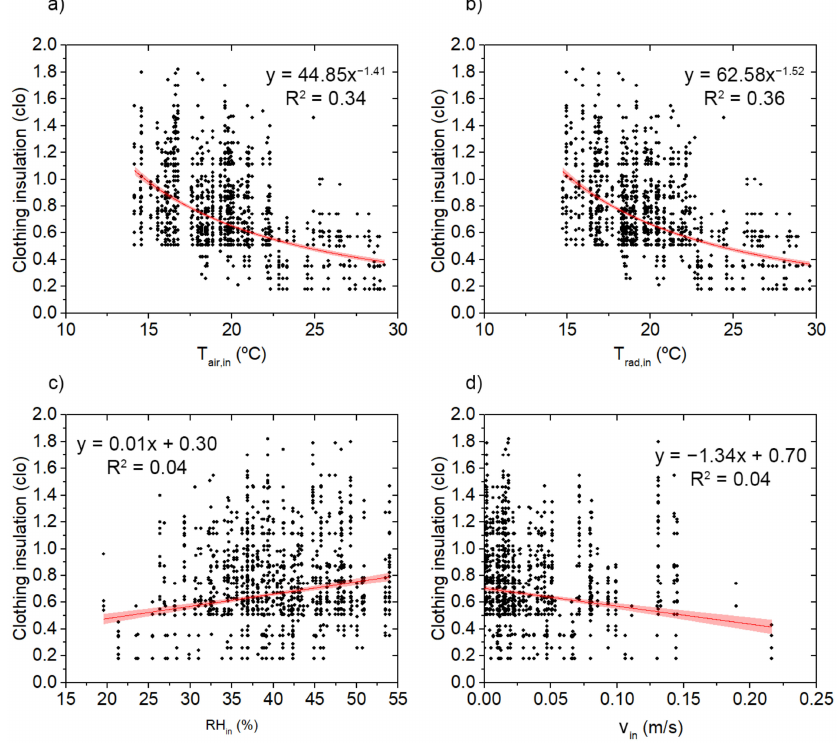
Figure 5. Relationship between indoor environmental factors and clothing insulation: ( a ) indoor air temperature; ( b ) indoor radiant temperature; ( c ) indoor RH; ( d ) indoor air velocity. The red line indicates the curve fit (95% confidence